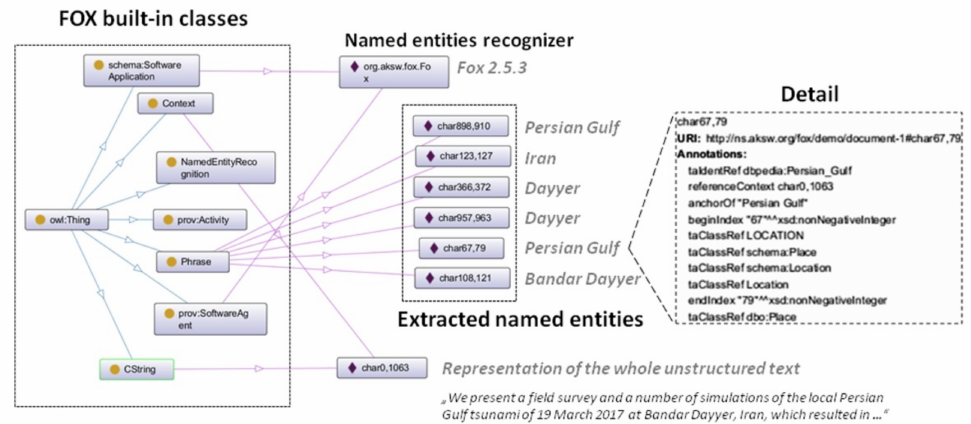
Figure 8. Visualisation of the resulted Fox-based RDF taxonomy in the Prot é g é